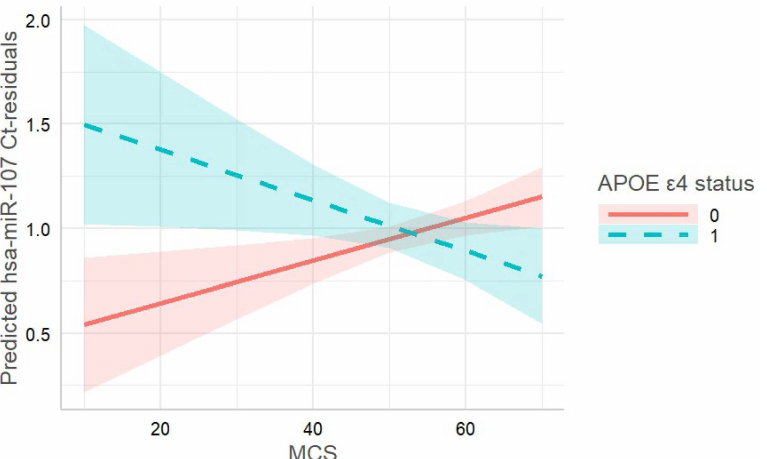
Figure 2. Interaction between APOE ε 4 status and MCS on Ct-values for has-miR-107 in TREND subsample ( n = 653). Analysis was adjusted for age, sex, miRNA batch, the first three genetic principal components, hematocrit, platelet count, smoking, education, and BMI. Subjects with low MCS and additionally carrying APOE ε 4 revealed higher Ct-values for hsa-miR-107, meaning that the level of hsa-miR-107 was reduced in these subjects compared to their genetic counterparts.